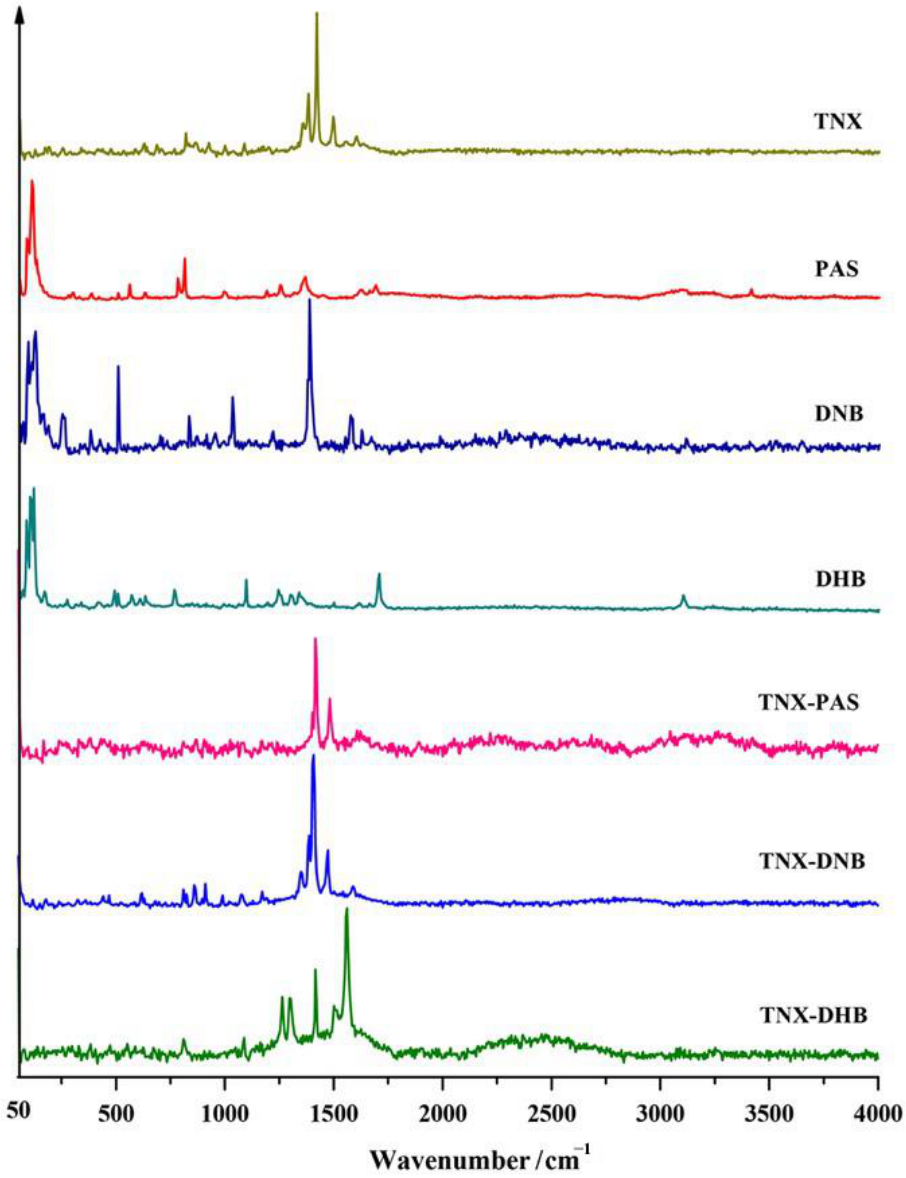
Figure 5. Raman spectra of TNX, CCFs, and the corresponding cocrystals/salt.